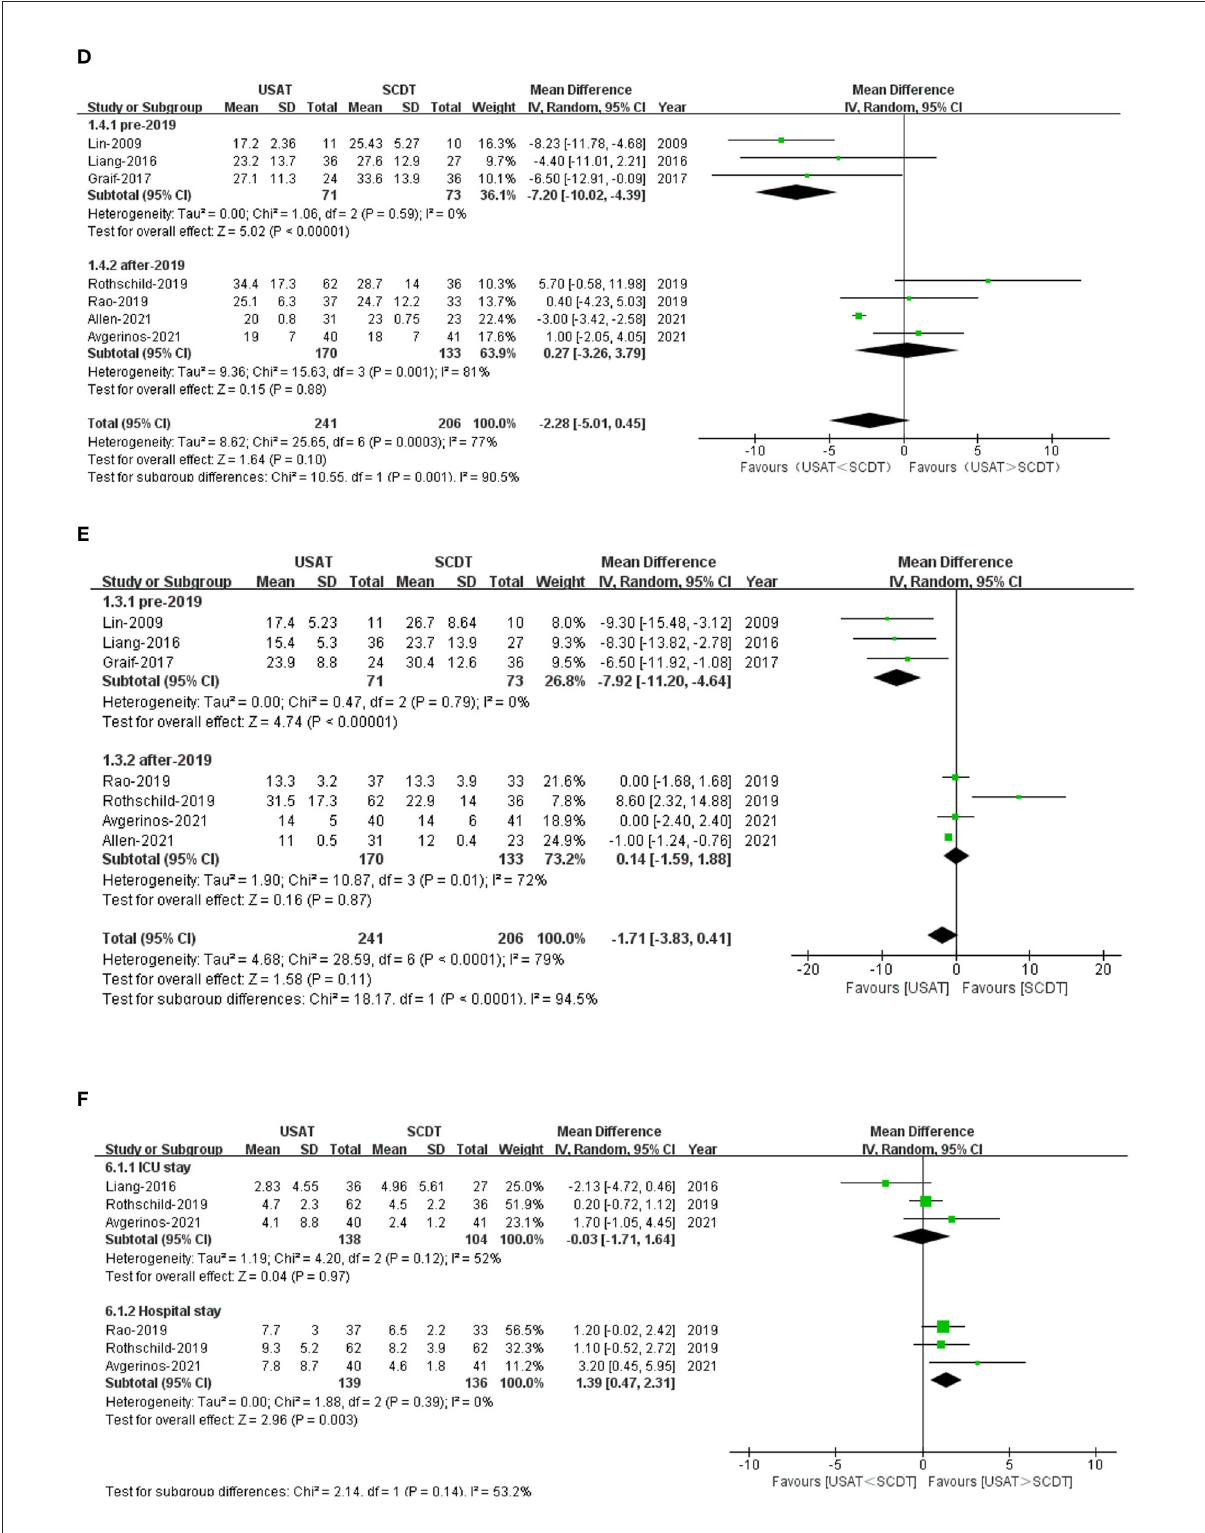
FIGURE3 (A) Forest of right ventricular-to-left ventricular ratio (RV/LV). (B) Forest of millers score. (C) Forest plot of pulmonary arterial systolic pressure (PASP). (D) Forest plot of dose of tPA. (E) Forest plot of time of tPA. (F) Forest plot of ICU and lenth of stay (LOS) in the